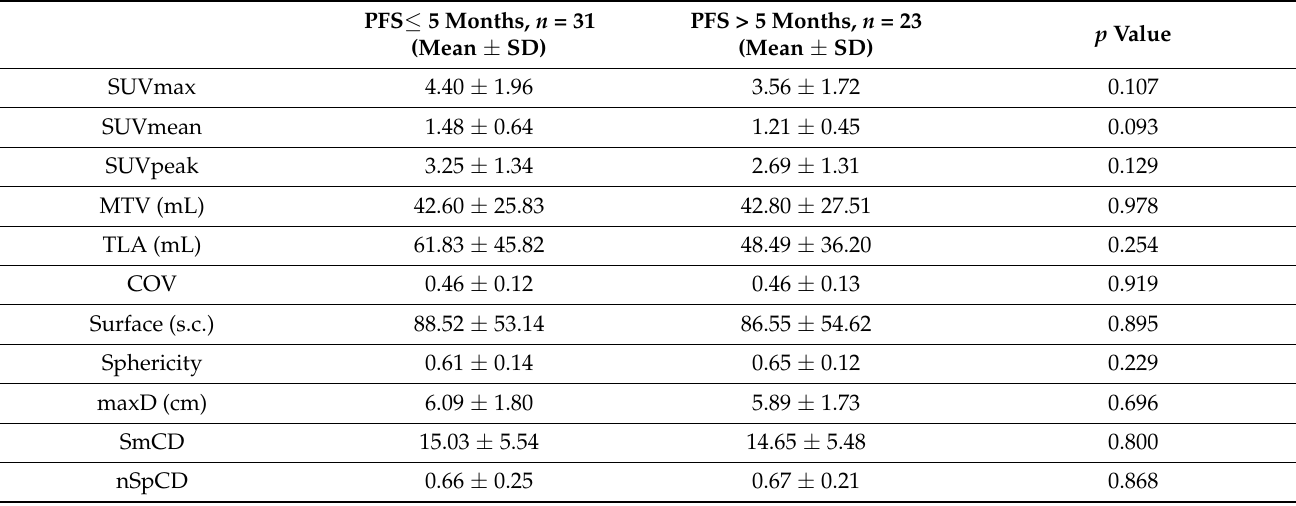
Table 4. Differences in the means of metabolic variables in patients with higher and lower or equal median PFS and